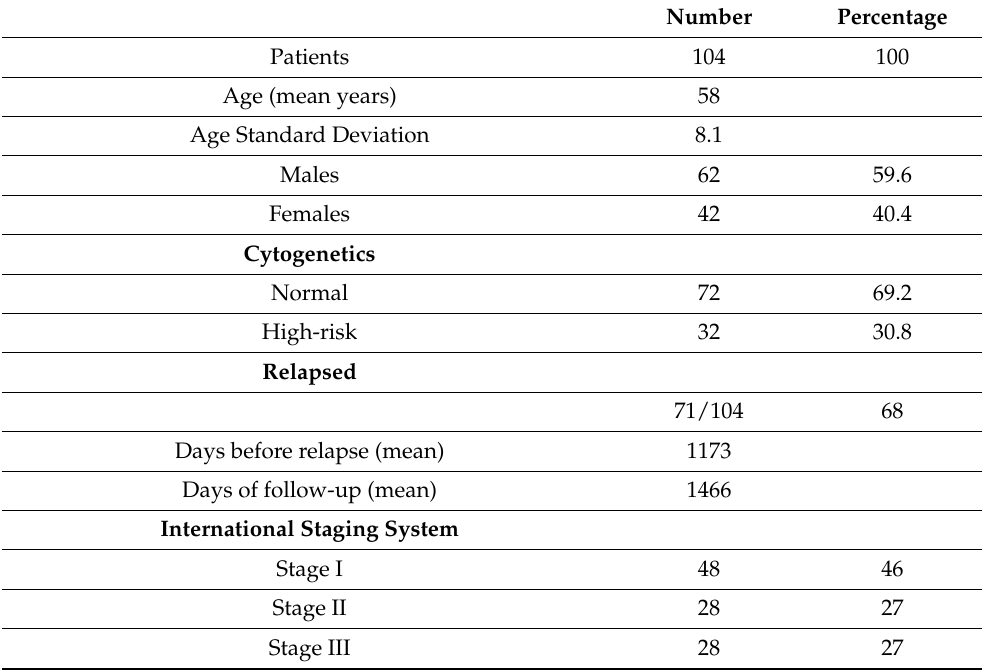
Table 2. Clinical data of the 104 MM patients included in the study. High-risk defines MM pa- tients carrying HR features, including del17p, t(4;14) or t(14,16), according to the FISH analysis. International Staging System includes stage I-III based on beta2-microglobulin and albumin